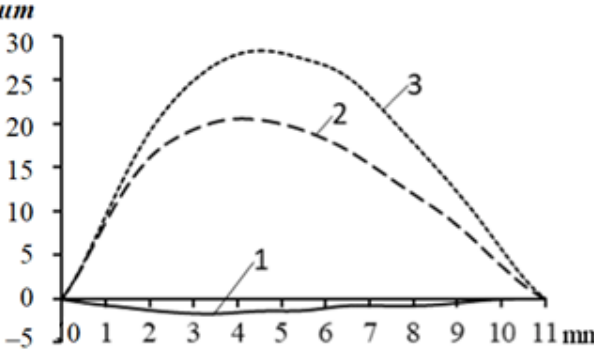
Figure 8. Representative view of smoothed surface profiles after erosion tests of different duration after subtraction of pre-test profiles for 20Kh13 steel samples without modification: 1 — 10 min; 2 — 195 min; 3 — 600 min.